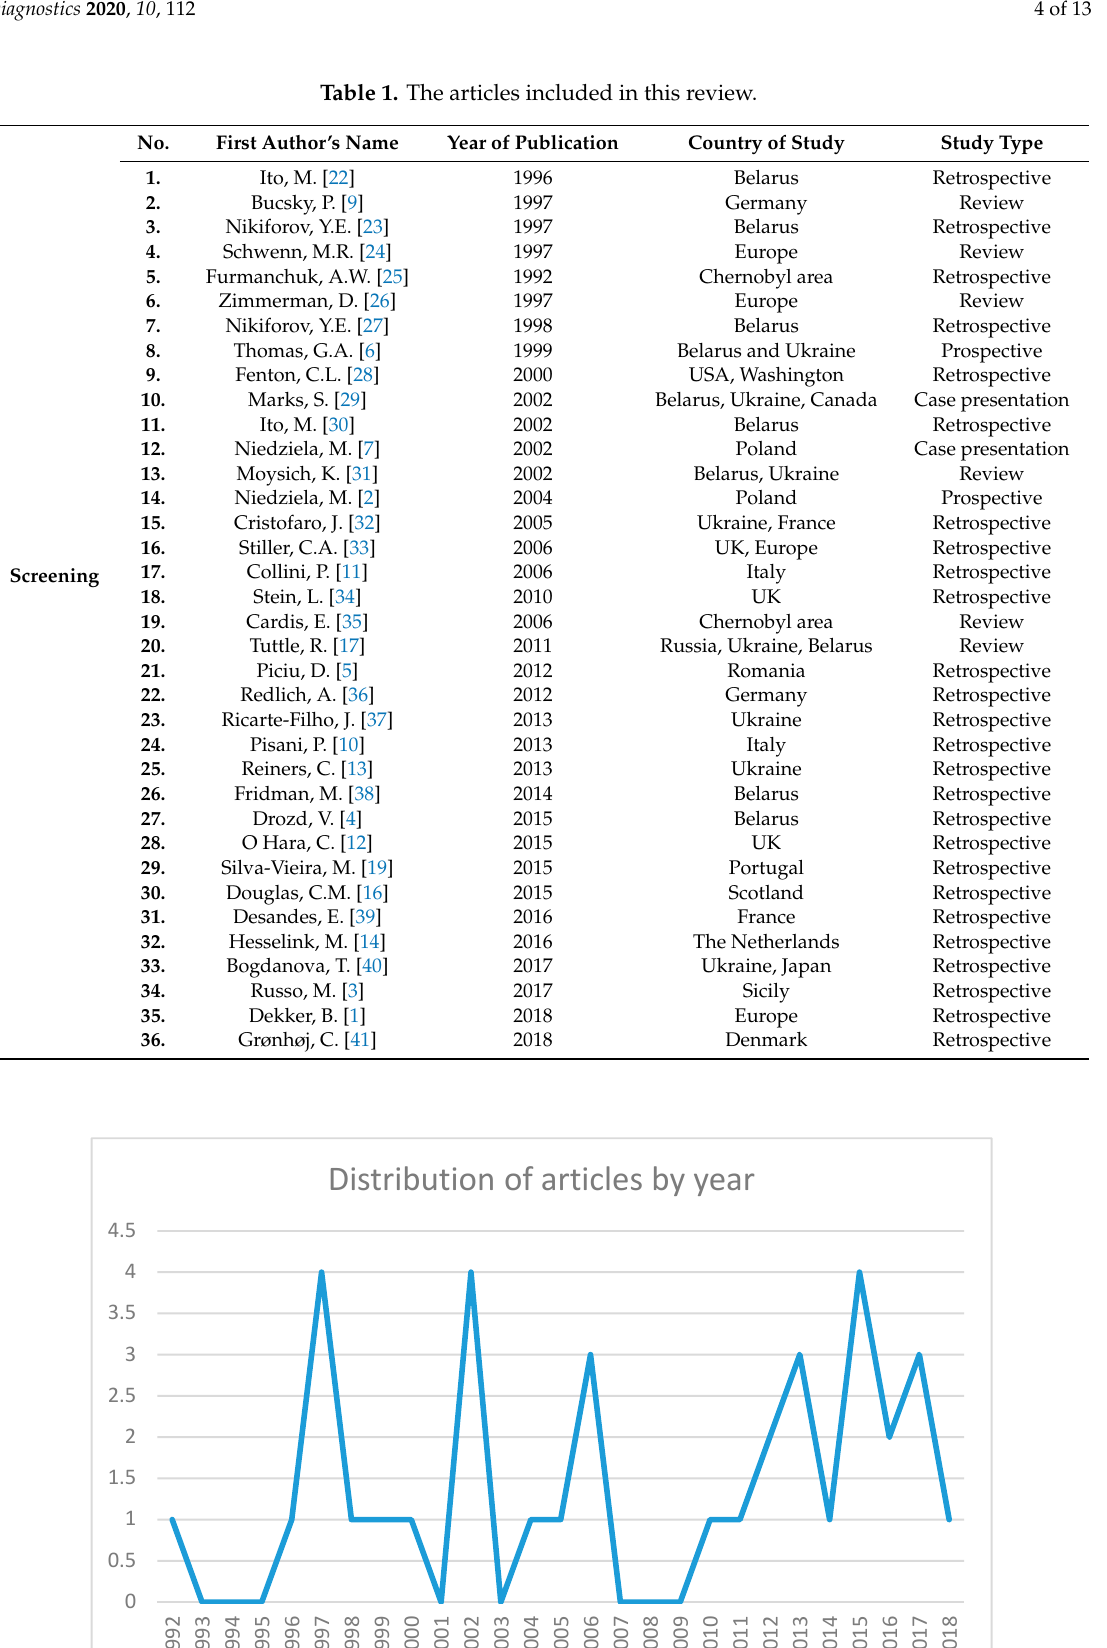
Table 1. The articles included in this review.